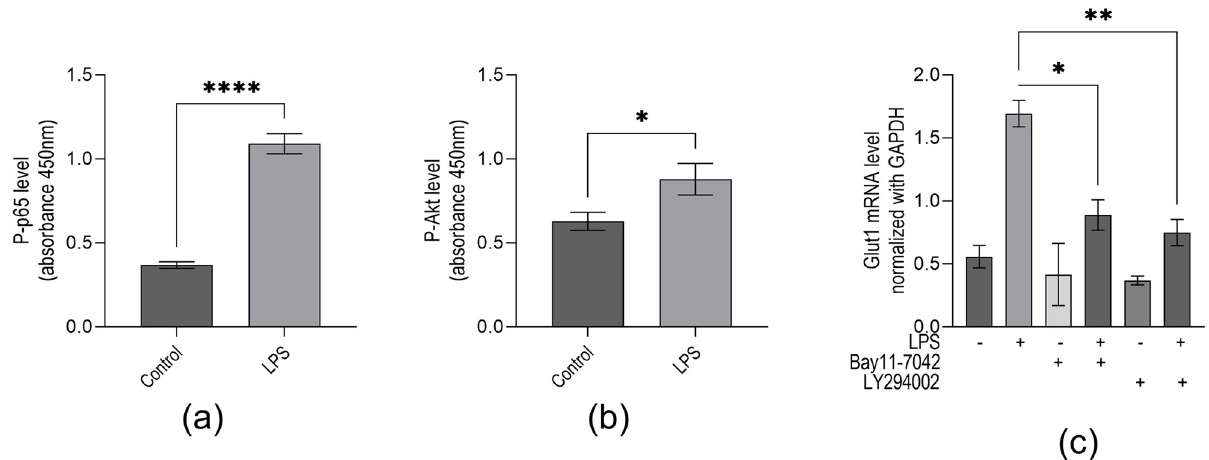
Fig 2. LPS induces phosphorylation of NF- κ B subunit p65 and phosphorylation of Akt subunit ser473, and NF- κ B and PI3k are associated with Glut1 expression in macrophages. ( a – c ) RAW264.7 cells were initially treated with IKK-inhibitor Bay11-7042 (15 μ M) or PI3k inhibitor LY7294002 (25 μ M) for 1 h and then treated with LPS for an additional 4 h for RNA analysis. ELISA analyzed proteins by targeting phospho-p65 (NF- κ B subunit) (panel a ). Akt proteins were analyzed by ELISA targeting Phospho-Ser473 (Akt subunit) (panel b ). ( c ) RNA was isolated from the above treated and control cells. RT-qPCR measured expressions (relative to GAPDH) of Glut1. GAPDH was used as a control. Data represent mean ± SD (n = 3); � p < 0.05, �� p < 0.001, ���� p < 0.00001.